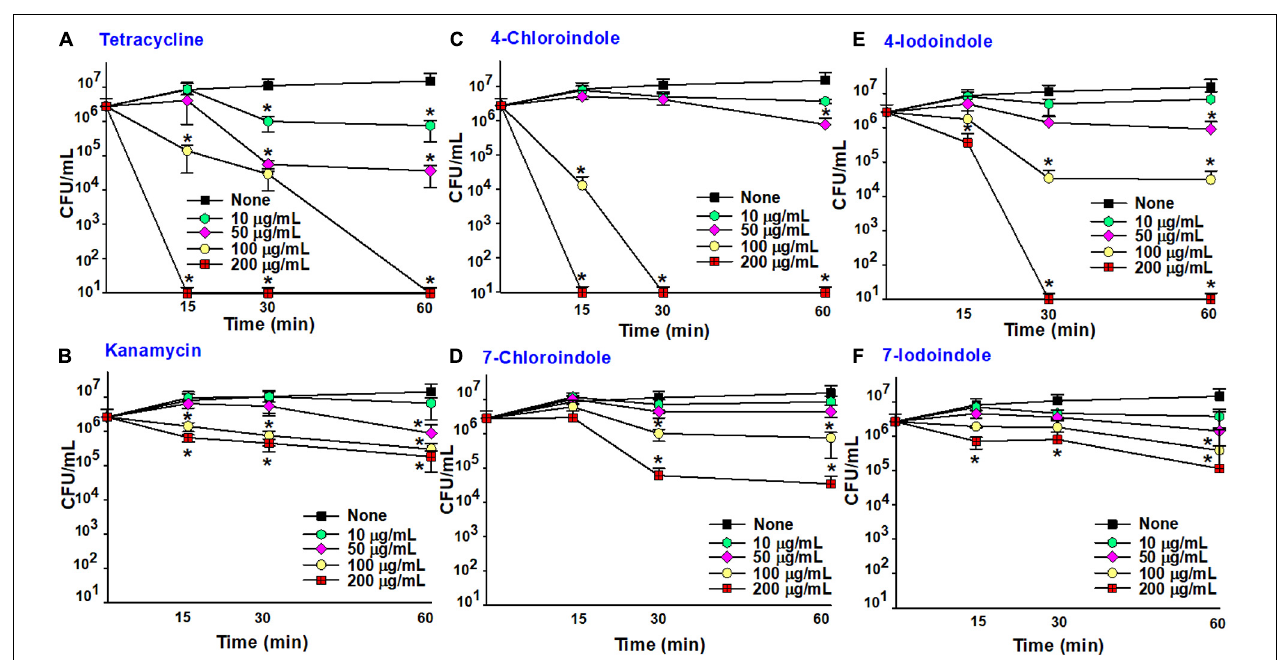
FIGURE 4 | Time-killing assay against V. parahaemolyticus. Tetracycline (A) , kanamycin (B) , 4-chloroindole (C) 7-chloroindole (D) , 4-iodoindole (E) , and 7-iodoindole (F). Asterisks (*) represent significant differences ( p < 0.05).